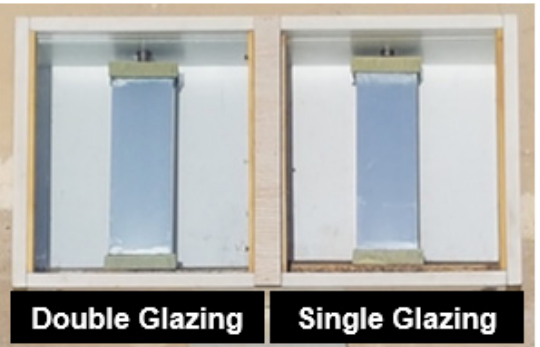
Figure 2. Single- and double-glazing experimental setting, Al water containers, sunny day, Date: 26 September 2021. 26 September